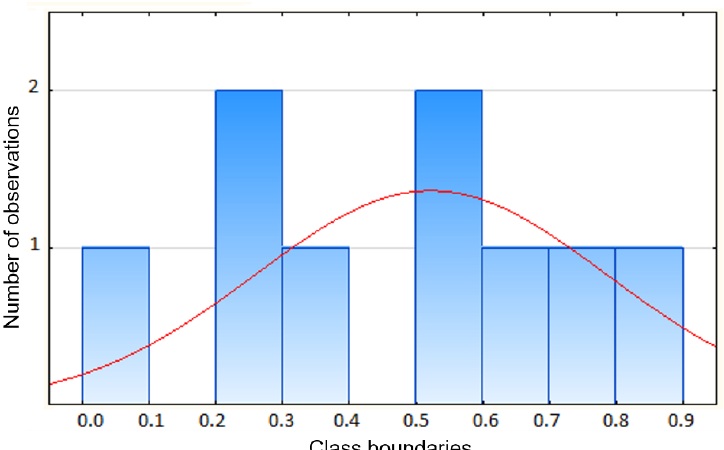
Figure 13. Shapiro–Wilk test for the difference between the measurement after 1 regeneration and the Figure 13. Shapiro – Wilk test for the difference between the measurement after 1 regeneration and measurement after 8 regenerations (W( α ,n)—critical value for fixed α , read from the quantile tables the measurement after 8 regenerations (W(α,n)—critical value for fixed α, read from the quantile for the Shapiro–Wilk test). tables for the Shapiro – Wilk test).